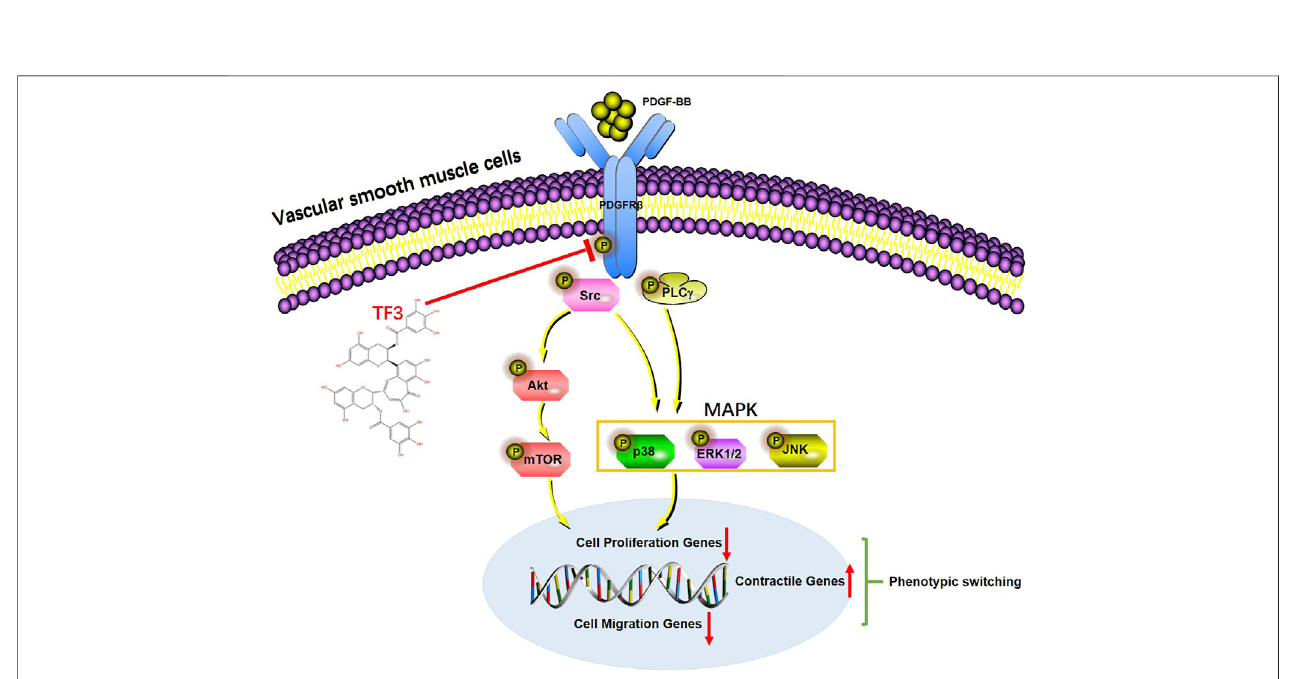
FIGURE 9 | A working model of the effect of thea fl avin-3,3 ′ -digallate (TF3) in PDGF-BB – induced phenotypic switching. Under vessel injury, vascular smooth cells (VSMCs) undergo phenotypic switching that leads to neointimal hyperplasia. TF3 inhibits the activation of PDGFR β and its downstream pathways to suppress PDGF- BB – induced VSMC phenotypic switching and thus reduces neointimal hyperplasia.